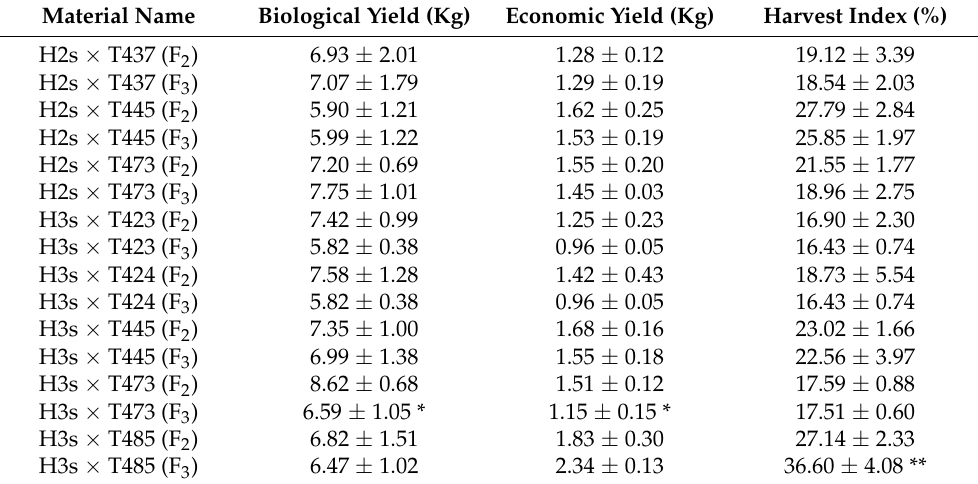
Table 2. Yield performance of F 2 and F 3